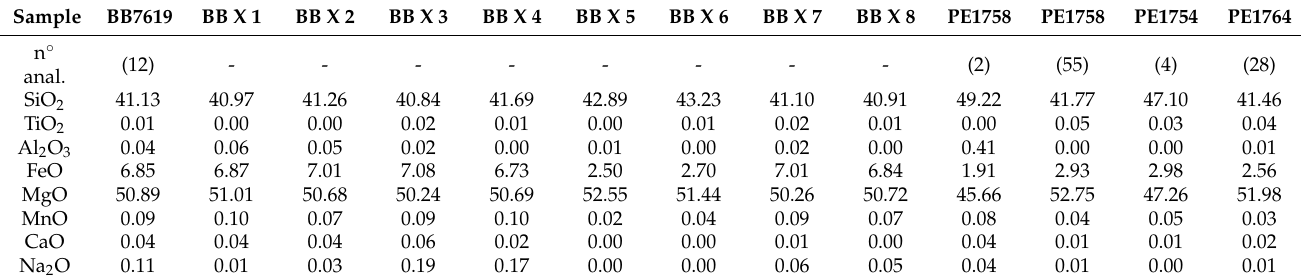
Table 2. Electron microprobe compositions (wt%) of accessory olivine from the Kraka chromitites. Sample